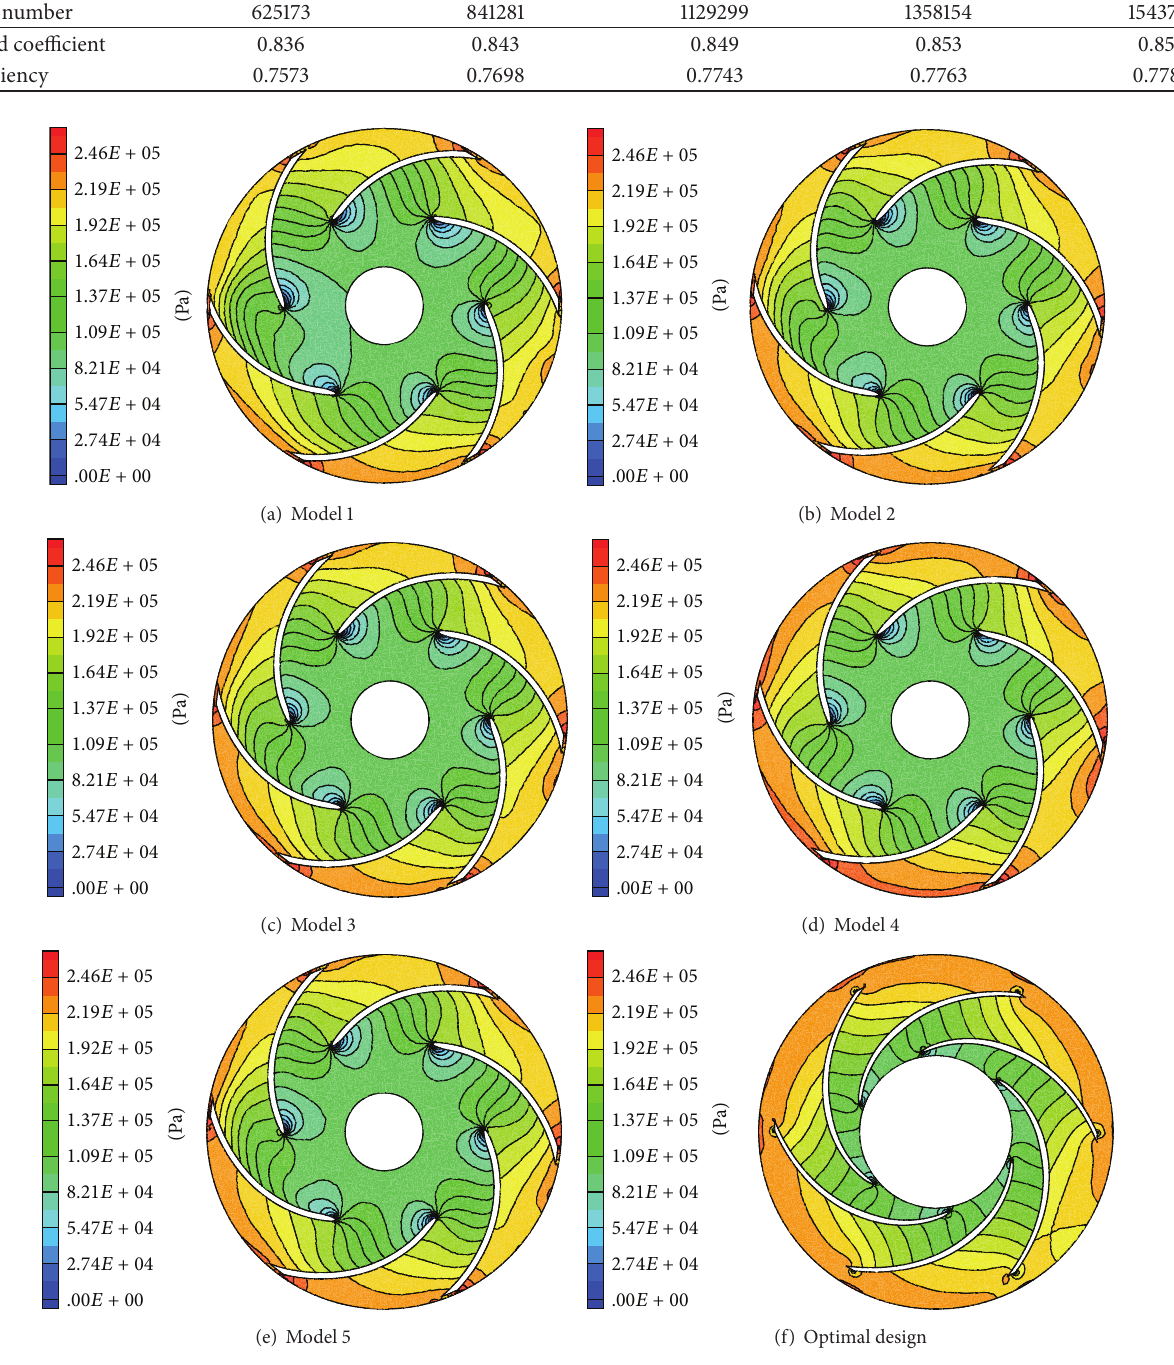
Figure 10: Static pressure